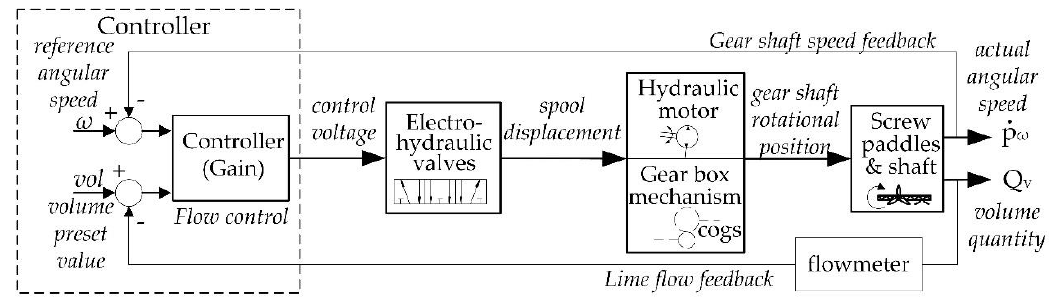
Figure 6. Schematic diagram of the lime tank controller.